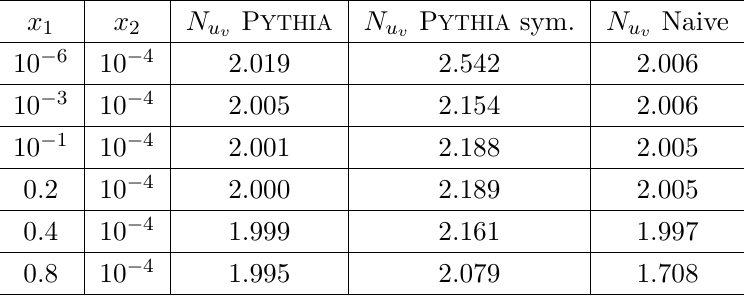
response function. In the ideal situation u ¯ uu = 2 v 2